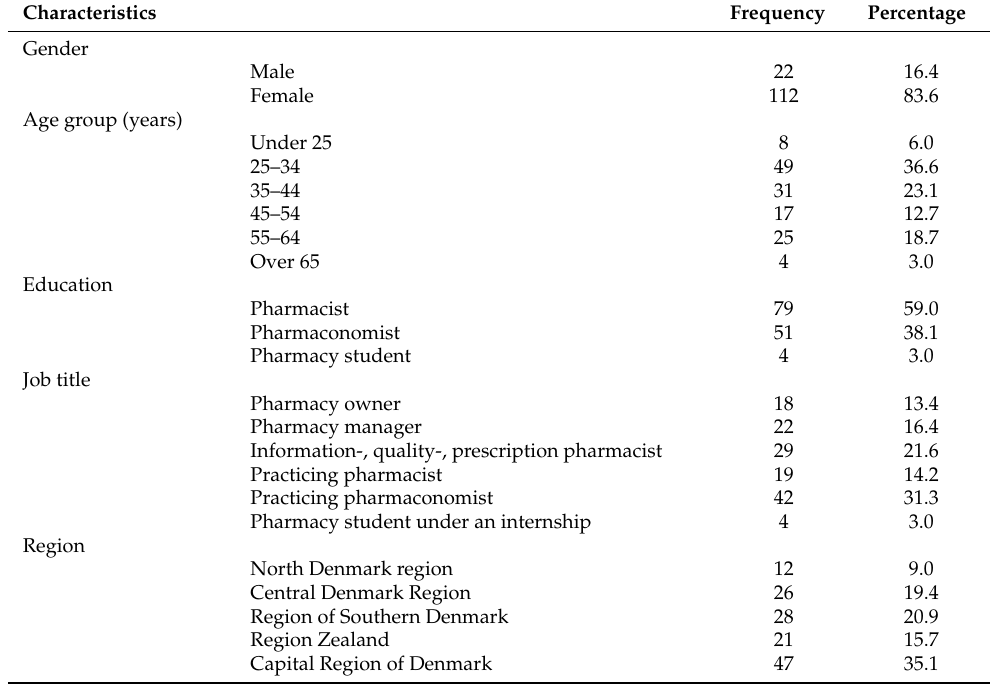
Table 2. Characteristics of study respondents (n =